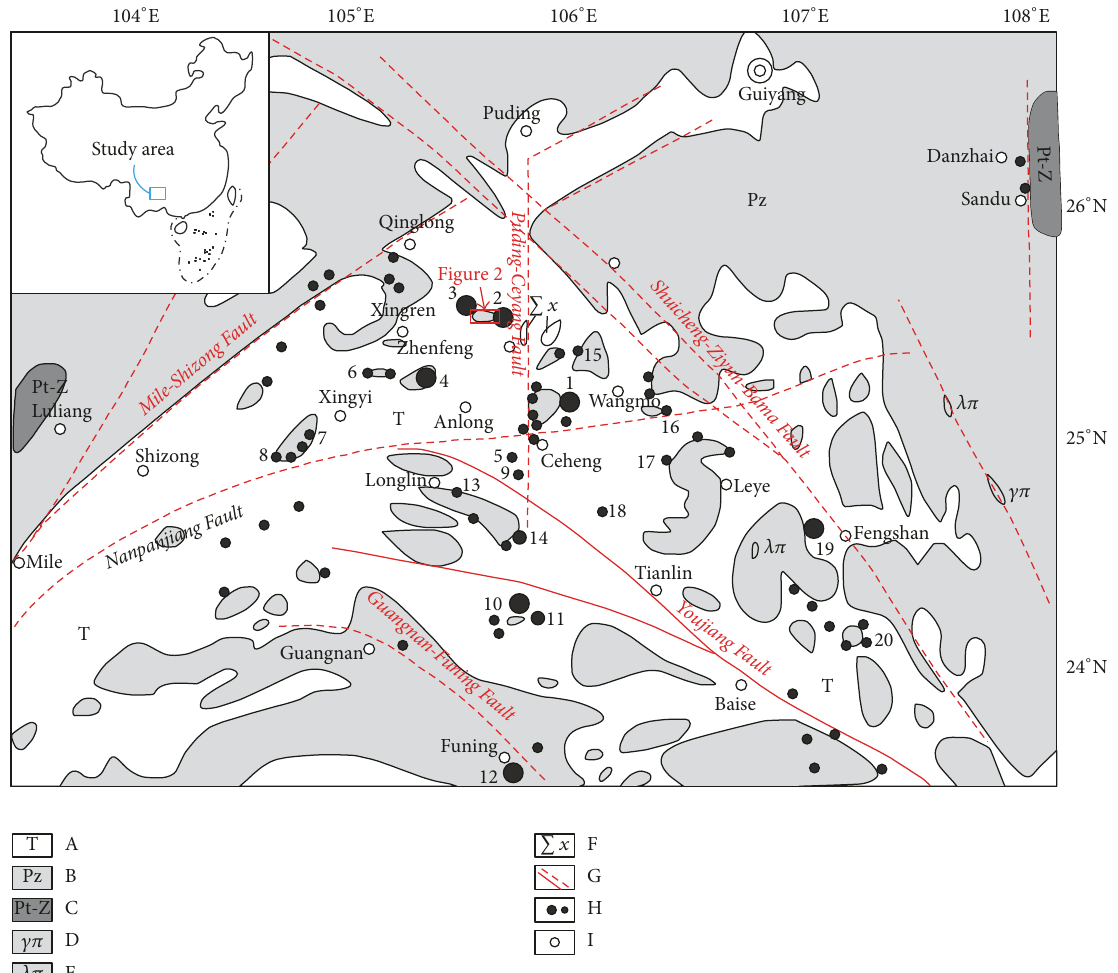
Figure 1: Geological sketch map showing the occurrence of Carlin-type gold deposits in the Dian-Qian-Gui gold-rich district (modified after Su et al., 2002). A, Triassic; B, Paleozoic; C, Proterozoic; D, late Yanshanian granite porphyry; E, late Yanshanian quartz porphyry; F, late Yanshanian alkaline ultrabasic rock; G, fault; H, gold deposit; I, towns, including (1) Lannigou, (2) Shuiyindong, (3) Zimudang, (4) Getang, (5) Yata, (6) Nibao, (7) Xiongwu, (8) Lubuge, (9) Banqi, (10) Gaolong, (11) Badu, (12) Gedang, (13) Maxiong, (14) Longhuo, (15) Nage, (16) Lekang, (17) Langquan, (18) Baidi, (19) Jinya, and (20)